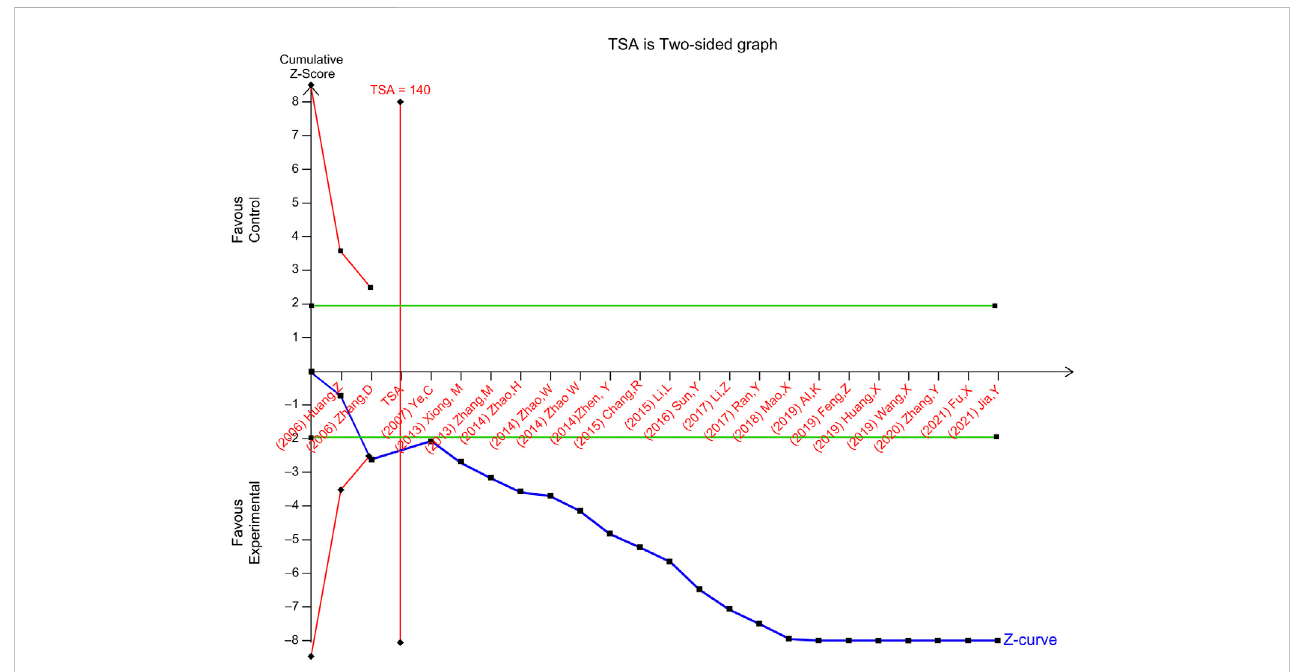
FIGURE 5 TSA of heart function ef fi cacy standard TSA, trial sequential